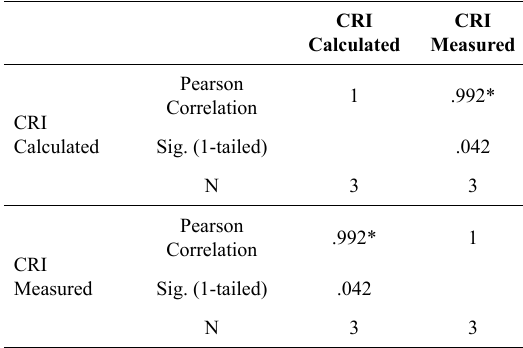
Table 11. Statistical results of comparison of experimental and calculated TC